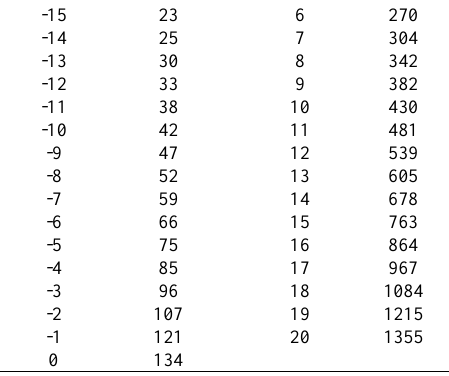
Table 4. The simulation results: T x Power vs Distance Max .